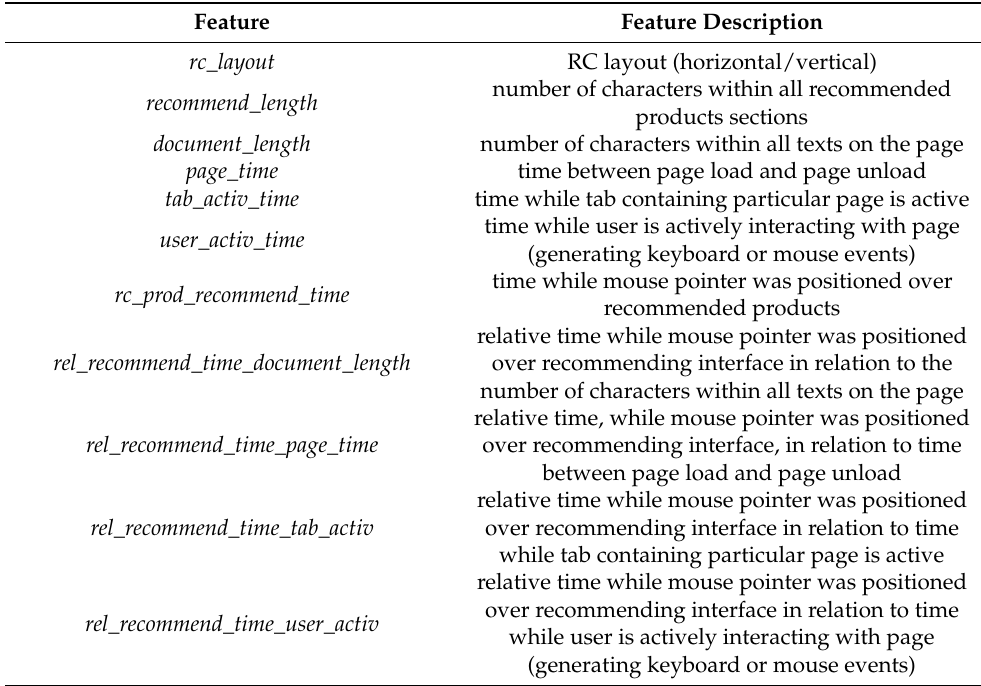
Table 4. Features generated based on data gathered via the e-commerce customer preference monitor (ECPM) monitoring